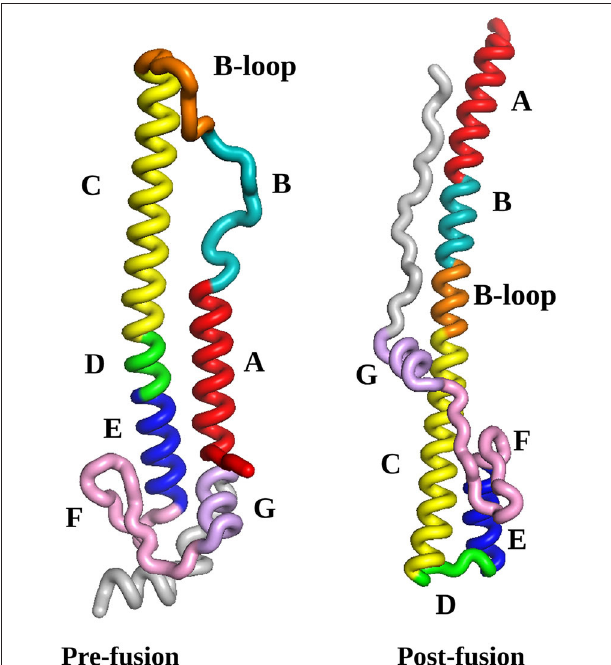
FIGURE 1 | The pre-fusion and post-fusion structures selected as the end points for the pathway search in the present work. The labels A to G refer to the regions identified from the crystal structure ( Ni et al., 2014). Here, we distinguish between the N-terminal section of the B-loop, which readily forms an alpha helical conformation (positions 56-66), from the C-termimal section, which converts later in the pathway (positions 67-75). The coloring scheme reflects sections of the protein that can be identified with rearrangements in specific parts of the pathway, as follows: red, helix A (positions 38-55); cyan, helix B (positions 56-66); orange, B-loop (positions 67-75); yellow, helix C (positions 76-105); green, loop D (positions 106-111); blue, helix E (positions 112-125); pink, beta-hairpin F (residues 126-144); mauve, helix G (residues 145-154); gray, C-terminal fragment (residues 155-181); all structures were visualized using VMD ( Humphrey et al., 1996). The numbering scheme starts from HA2 after